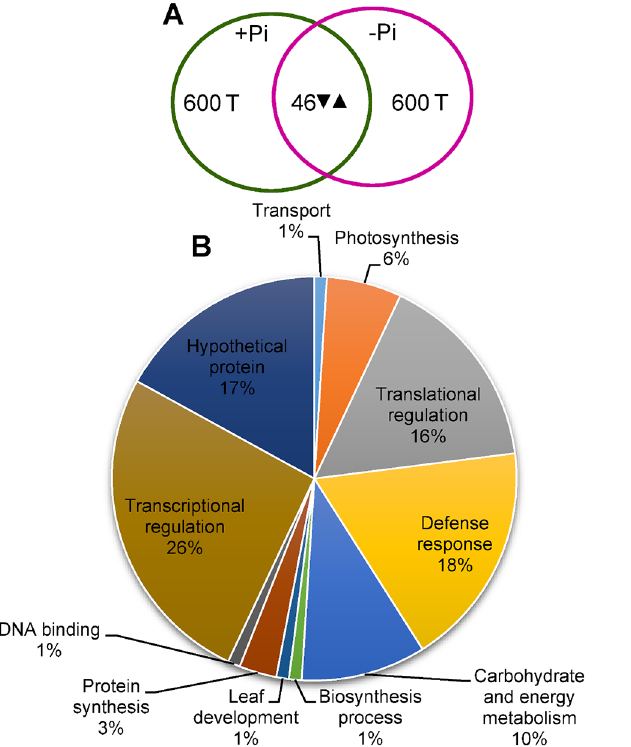
Fig 4. Comparative analysis of protein profile in leaves of tomato ( Solanum lycopersicum L.) to Pi starvation. One week after germination tomato plants were supplied with sufficient Pi (1 M KH 2 PO 4 ) or deficient Pi (0 M KH 2 PO 4 ) for 10 days. (A) Venn diagram, the numbers in Venn diagram correspond to the protein spots present in 2-DE patterns. Upward and downward arrows denote increased or decreased protein expression under combined treatments. (B) Functional classification of identified proteins, the proteins identified were classified based on their putative biological functions according to gene ontology (www.geneontology.com).